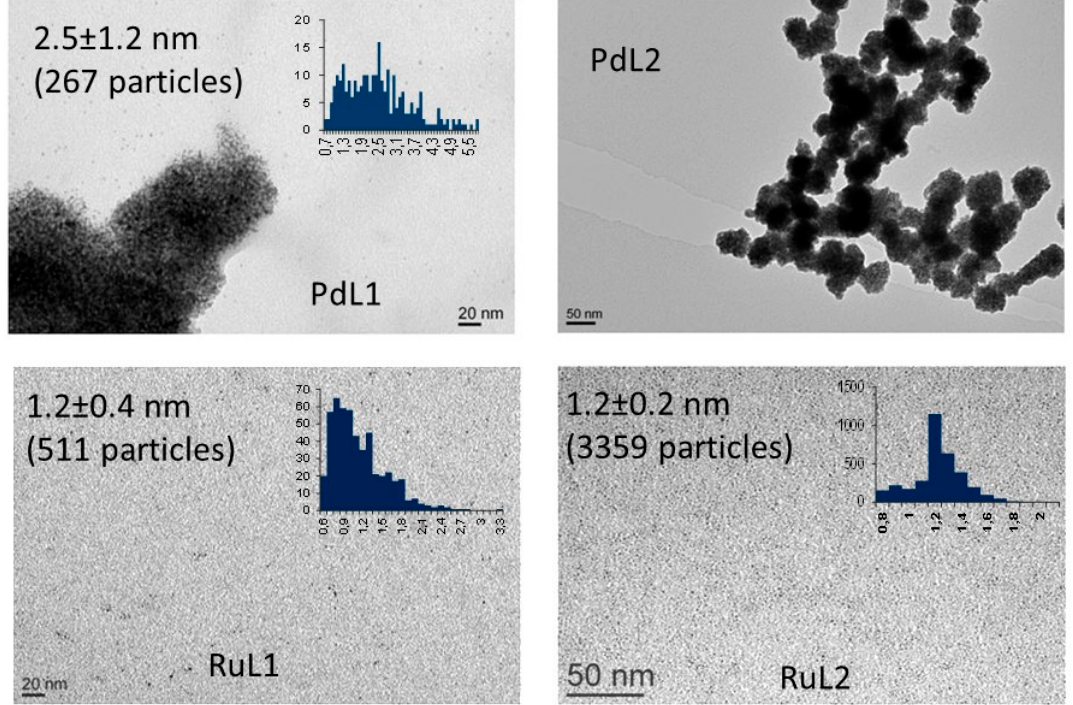
Figure 1. TEM (Transmission Electron Microscopy) images of PdL1 and PdL2 ( top ); and RuL1 and RuL2 ( bottom ); insets represent the corresponding size distribution diagrams.